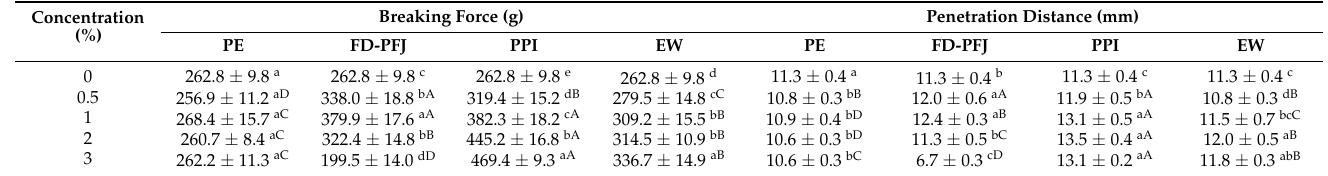
Table 2. Breaking force and penetration distance of the Pacific whiting surimi gels with four different inhibitors (PE, FD-PFJ, PPI, and EW) at 0, 0.5, 1, 2, and 3% levels heated to 90 ◦ C directly. Breaking Force